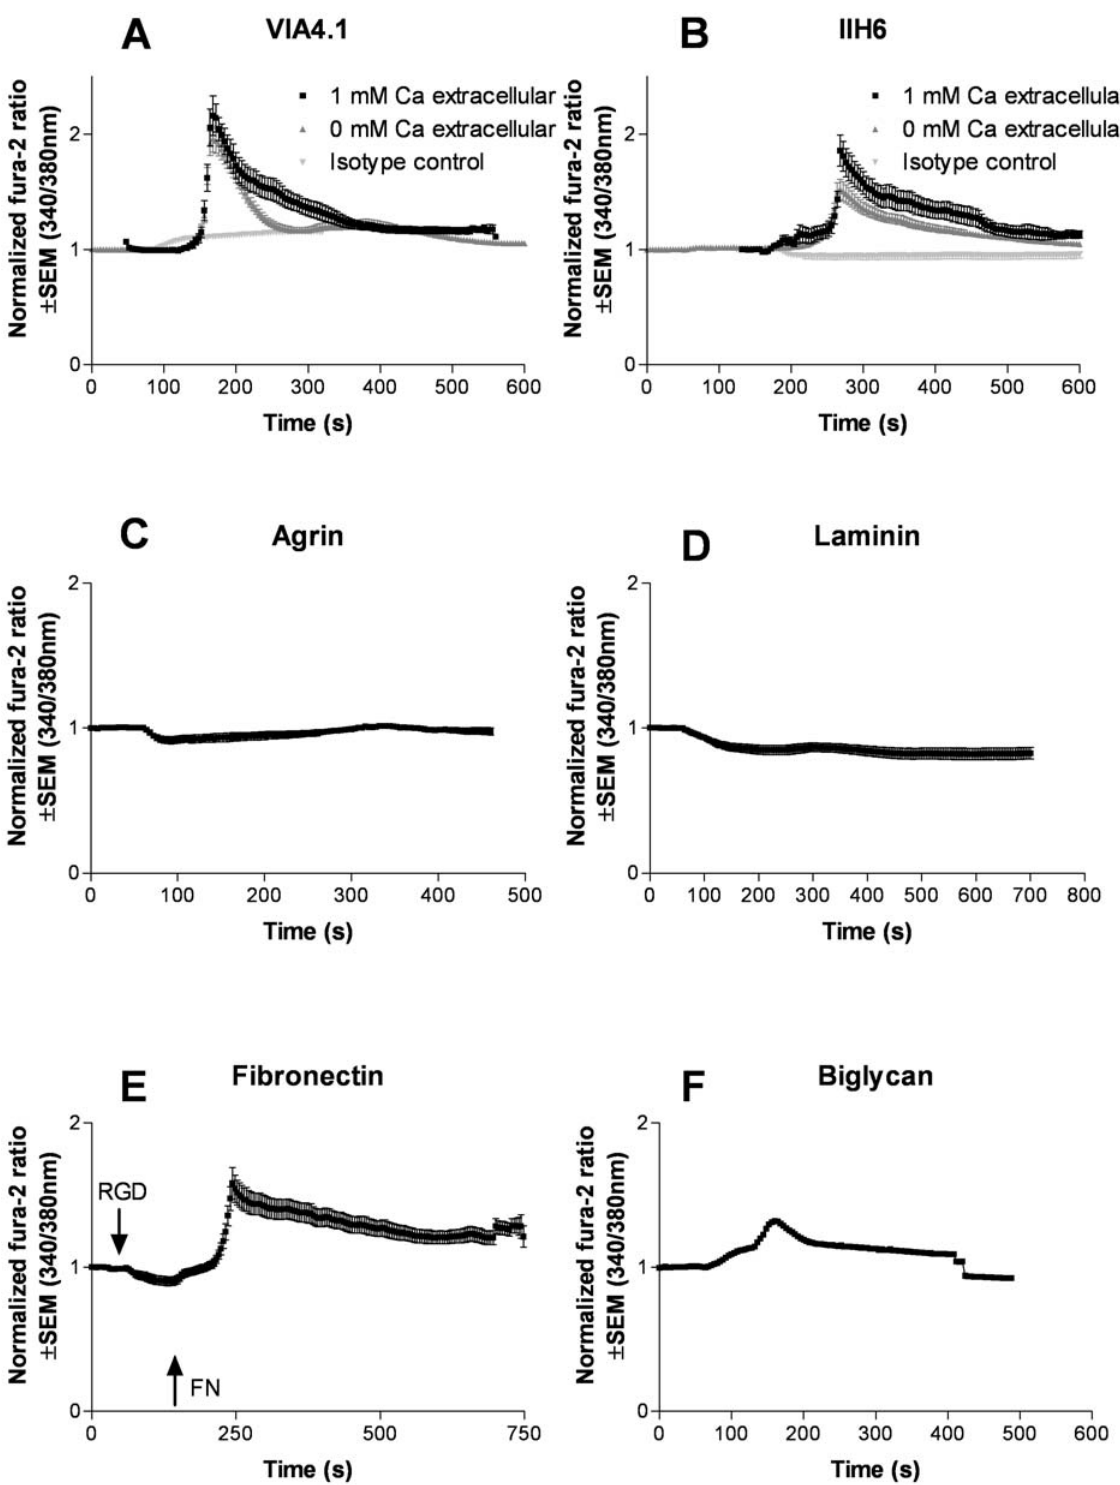
Figure 2. Calcium fluxes in cultured mouse podocytes after ligation of a -dystroglycan. Mouse podocytes were differentiated on collagen A coatings for 2 weeks. Intracellular calcium concentrations were monitored by the fura-2 method, with and without extracellular calcium. Both a - dystroglycan specific monoclonal antibodies induced calcium fluxes, most likely from intracellular stores. Isotype controls were negative (A, B). The laminin G modules-containing proteins agrin and laminin were unable to induce a calcium influx in podocytes (C, D). From the natural ligands of a - dystroglycan tested, fibronectin induced the most pronounced calcium influx. Note that blocking of potential integrin binding sites with a RGD peptide did not influence the fibronectin effect (E). The proteoglycan biglycan induced a modest calcium influx (F).